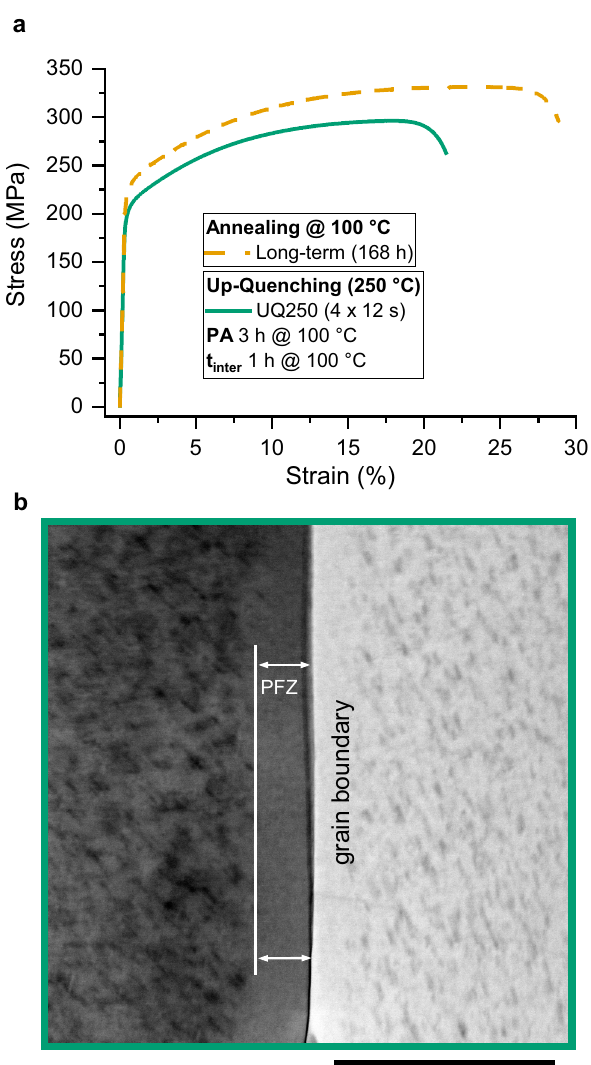
Fig. 5 Stress – strain diagram and corresponding microstructure of UQ250 examined by STEM. a Stress – strain curves resulting from up-quenching strategy UQ250 and long-term medium-temperature annealing. b LAADF- STEM micrograph of UQ250 shows a pronounced precipitate-free zone (PFZ) along a representative grain boundary. The scale bar corresponds to 150 nm. “ PA ” stands for pre-annealing.